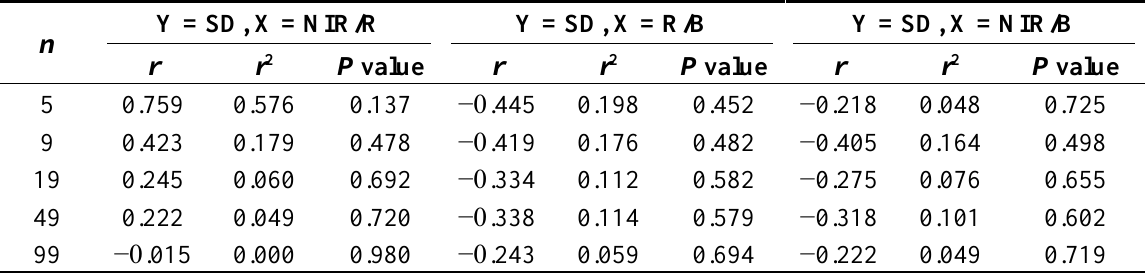
Table 5. Correlation analysis result between ln(SD) and either ln(NIR/R), ln(R/B) or ln(NIR/B), using the average